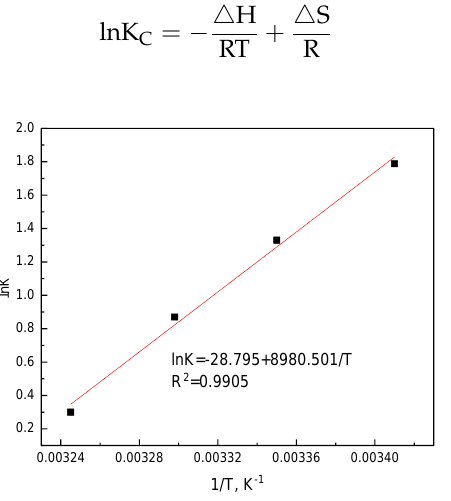
Figure 8. Van’t Hoff plot for the investigated adsorbents. Table 5. Thermodynamic parameters for the absorption of Pd(CN) 42 − .